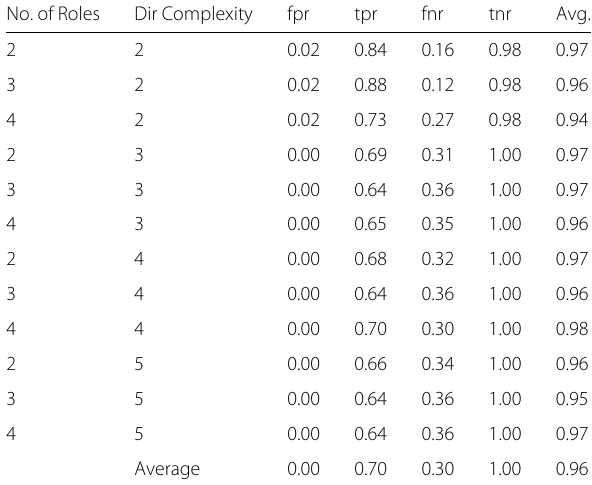
Table 4 Results from performing experimental analysis No. of